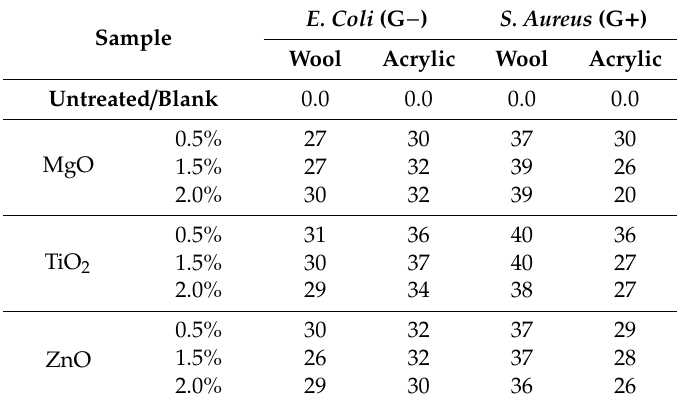
Table 6. Antibacterial performance of unprinted wool and acrylic fabrics treated with metal oxide